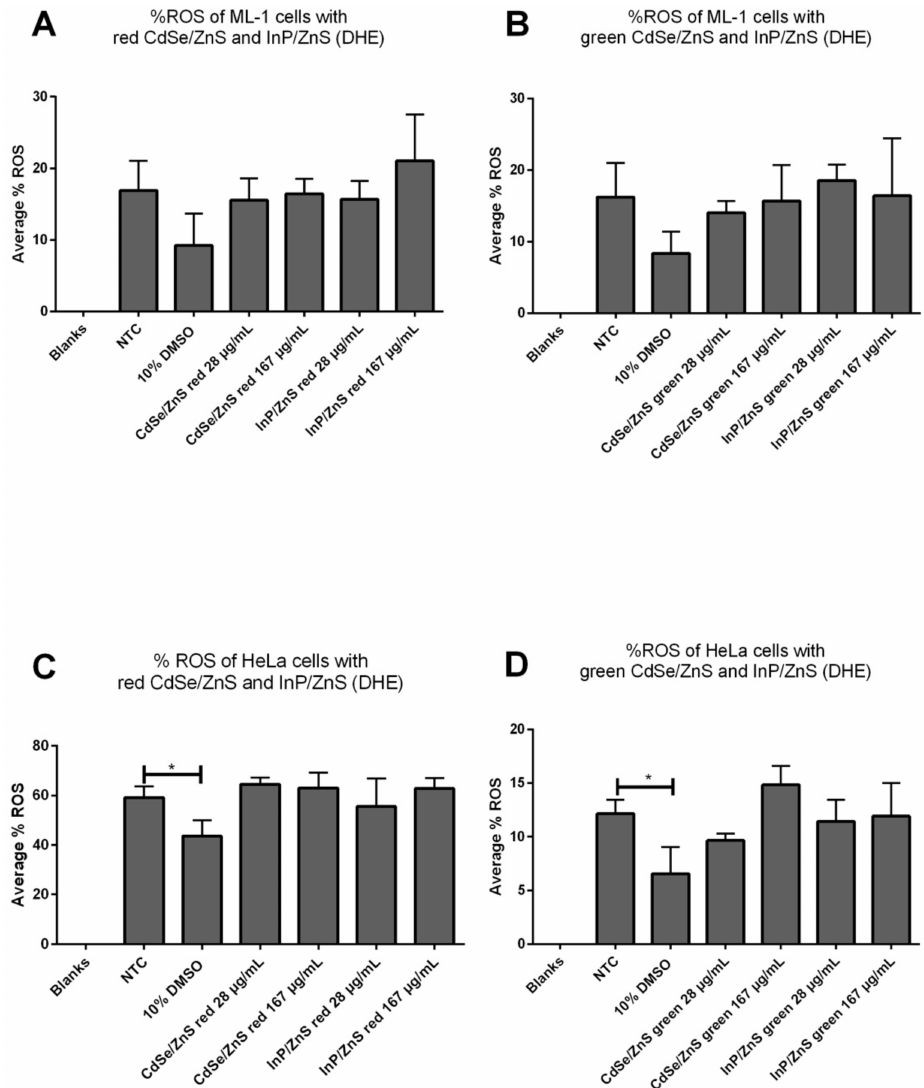
Figure 2. ROS measurements with DHE at varied CdSe/ZnS and InP/ZnS QD concentrations. ( A ) ML-1 cells were treated with 28 µ g/mL and 167 µ g/mL of red CdSe/ZnS and InP/ZnS QDs for 24 h. ( B ) ML-1 cells were treated with 28 µ g/mL and 167 µ g/mL of green CdSe/ZnS and InP/ZnS QDs for 24 h. ( C ) HeLa cells were treated with 28 µ g/mL and 167 µ g/mL of red CdSe/ZnS and InP/ZnS QDs for 24 h. ( D ) HeLa cells were treated with 28 µ g/mL and 167 µ g/mL of green CdSe/ZnS and InP/ZnS QDs for 24 h. Statistically significant results are indicated based on p -values: * = p <